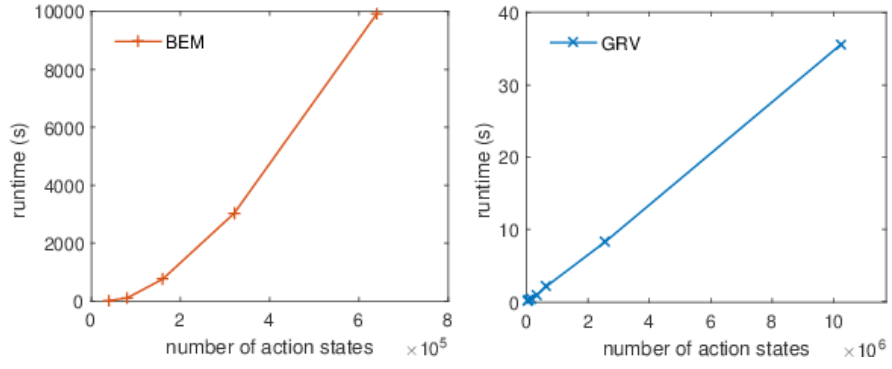
Figure 5. Scaling of runtime results for the ant-on-a-grid